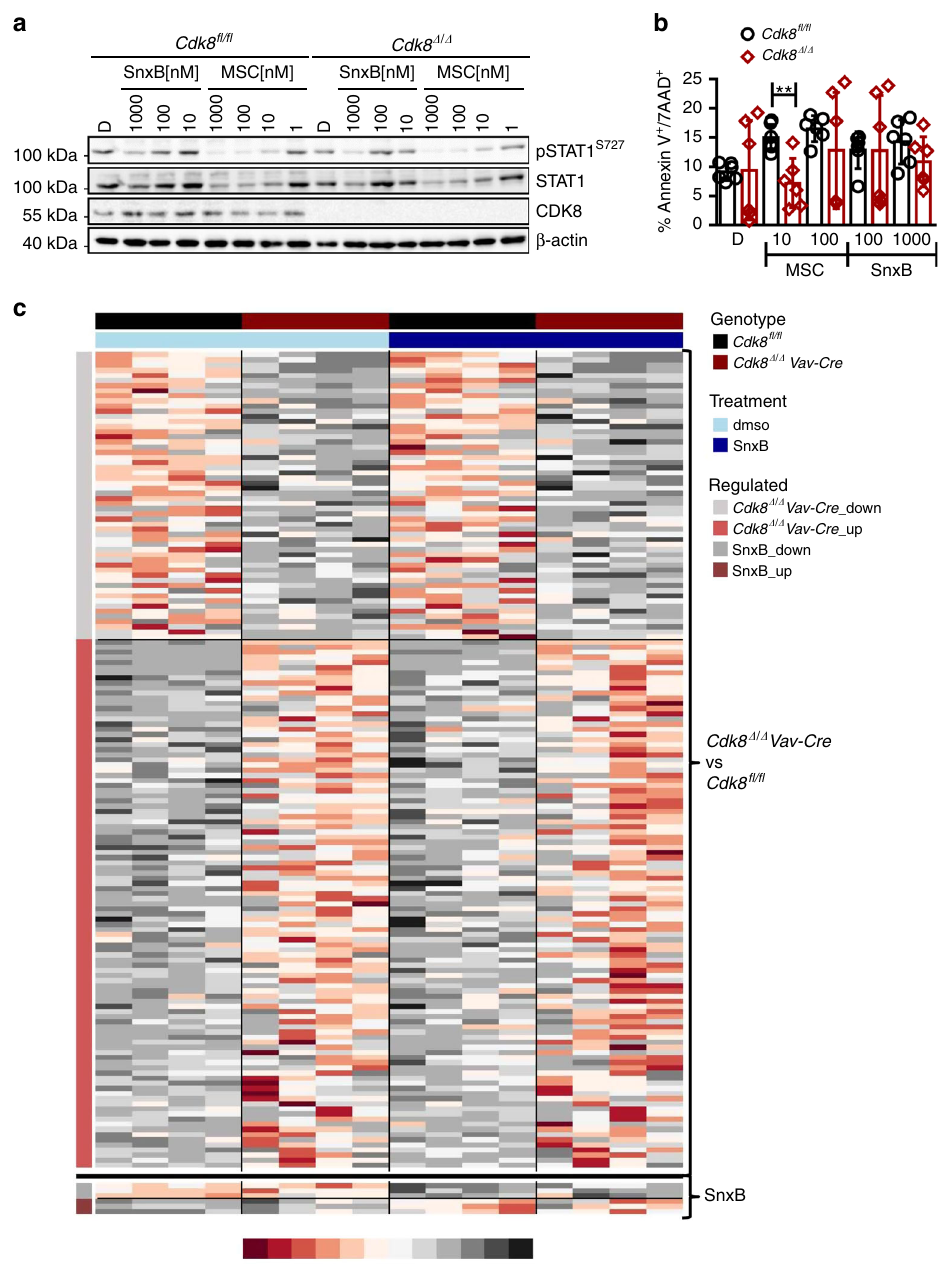
Fig. 5 Kinase inhibition fails to mimic the effects of Cdk8 deletion. a Immunoblotting of pSTAT1 S727 of BCR-ABL1 p185 + cells after 48 h incubation with increasing concentrations of MSC or Senexin B (SnxB). Induction of phosphorylation was induced by 30 min IFN- β stimulation prior collection. β -Actin served as a loading control. b AnnexinV/PI staining (after 48 h) of BCR-ABL1 p185 + Cdk8 fl / fl and BCR-ABL1 p185 + Cdk8 Δ / Δ Vav-Cre cell lines in the presence of indicated Senexin B or MSC concentrations. DMSO (0.1%) served as solvent control. Bars represent means ± SD from two independent experiments ( n =